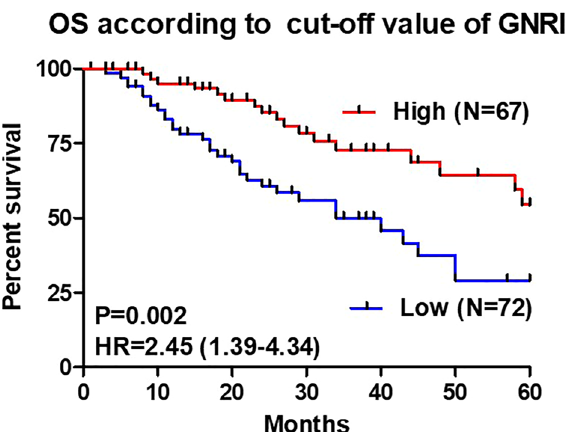
Figure 2. Overall survival curves between the Low and High GNRI groups. The High group shows a better prognosis than the Low